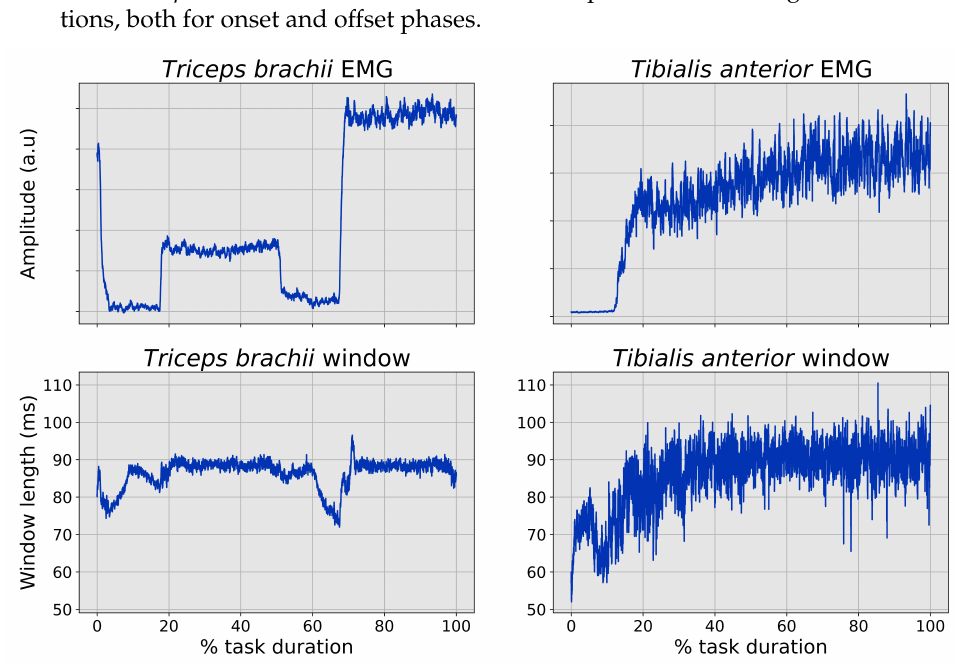
Figure 4. Average sEMG envelope and time-varying time constant behavior for the two datasets.